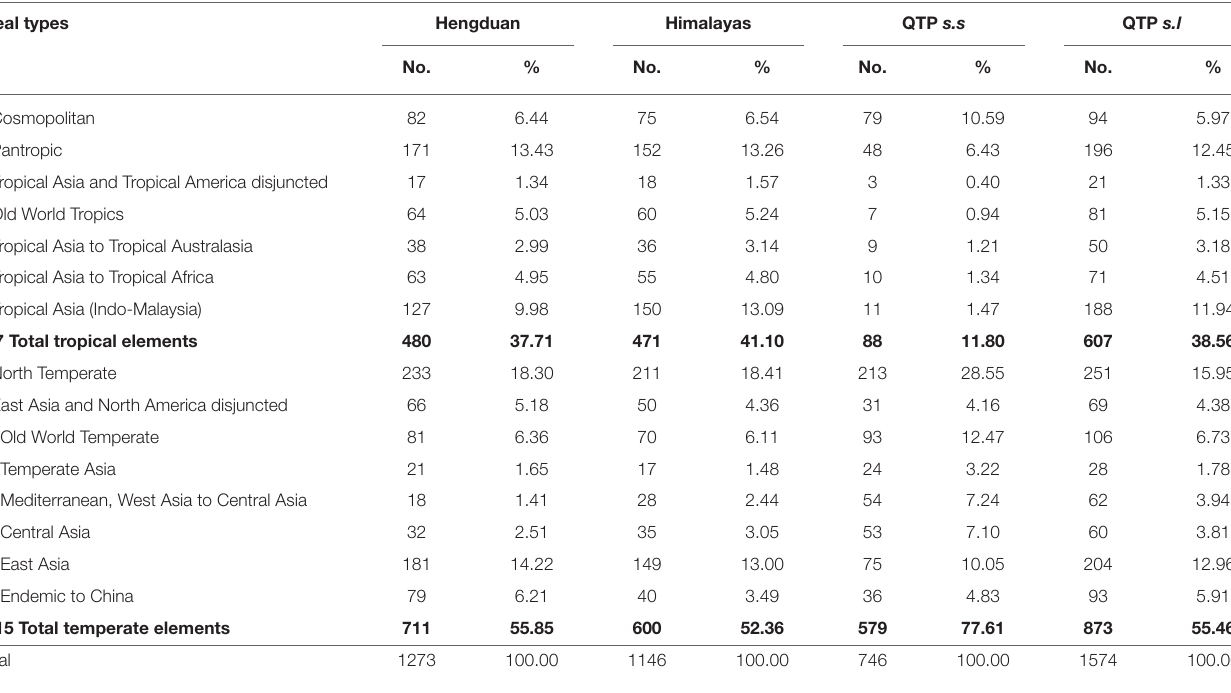
TABLE 6 | Geographical elements of seed plants of the Hengduan Mountains, the Himalayas, the Qinghai-Tibet Plateau s.s. , and the Qinghai-Tibet Plateau s.l. at the genus level. Areal